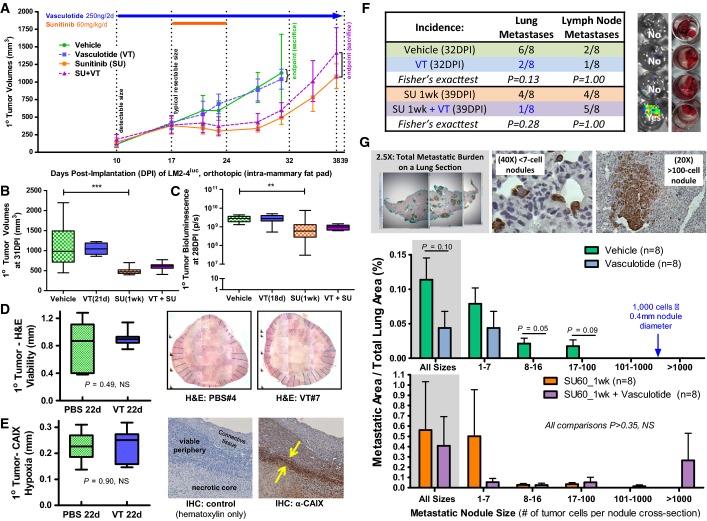
Vasculotide delays the dissemination of spontaneous lung metastases from orthotopic breast cancer (LM2-4luc) xenografts without having effect on primary tumors

A–C Vasculotide (VT) did not alter the growth kinetics of orthotopic LM2-4luc tumors; n = 8 mice per group. Sunitinib (SU) treatment significantly lowered primary tumor burden as measured by volume (B: one-way ANOVA, P < 0.01) or bioluminescent activity (C: one-way ANOVA, P < 0.001).

D VT treatment did not alter the mean thickness of the viable peripheral regions of primary tumors, as quantified by H&E histological staining.

E VT treatment did not alter the mean thickness of the CAIX+ hypoxic edge between the viable periphery and necrotic core of a primary tumor; IHC control and sample images taken at 5× are shown.

F Ex vivo bioluminescent imaging suggests that VT treatment lowered the proportion of mice with metastatic involvement in the lungs, without the corresponding effect on lymphatic metastases. Representative bioluminescent vs. photographic images of dissected lungs in a 24-well plate are shown.

G Human LM2-4luc cells can be identified on histological sections of mouse lung tissue by IHC staining of human vimentin, a cytoskeletal protein. Size distribution analysis show VT monotherapy reducing the occurence of bigger metastatic nodules.

Data information: Means ± SD are depicted in (A). Means ± SEM and P values from t-tests are depicted in (B–E and G).